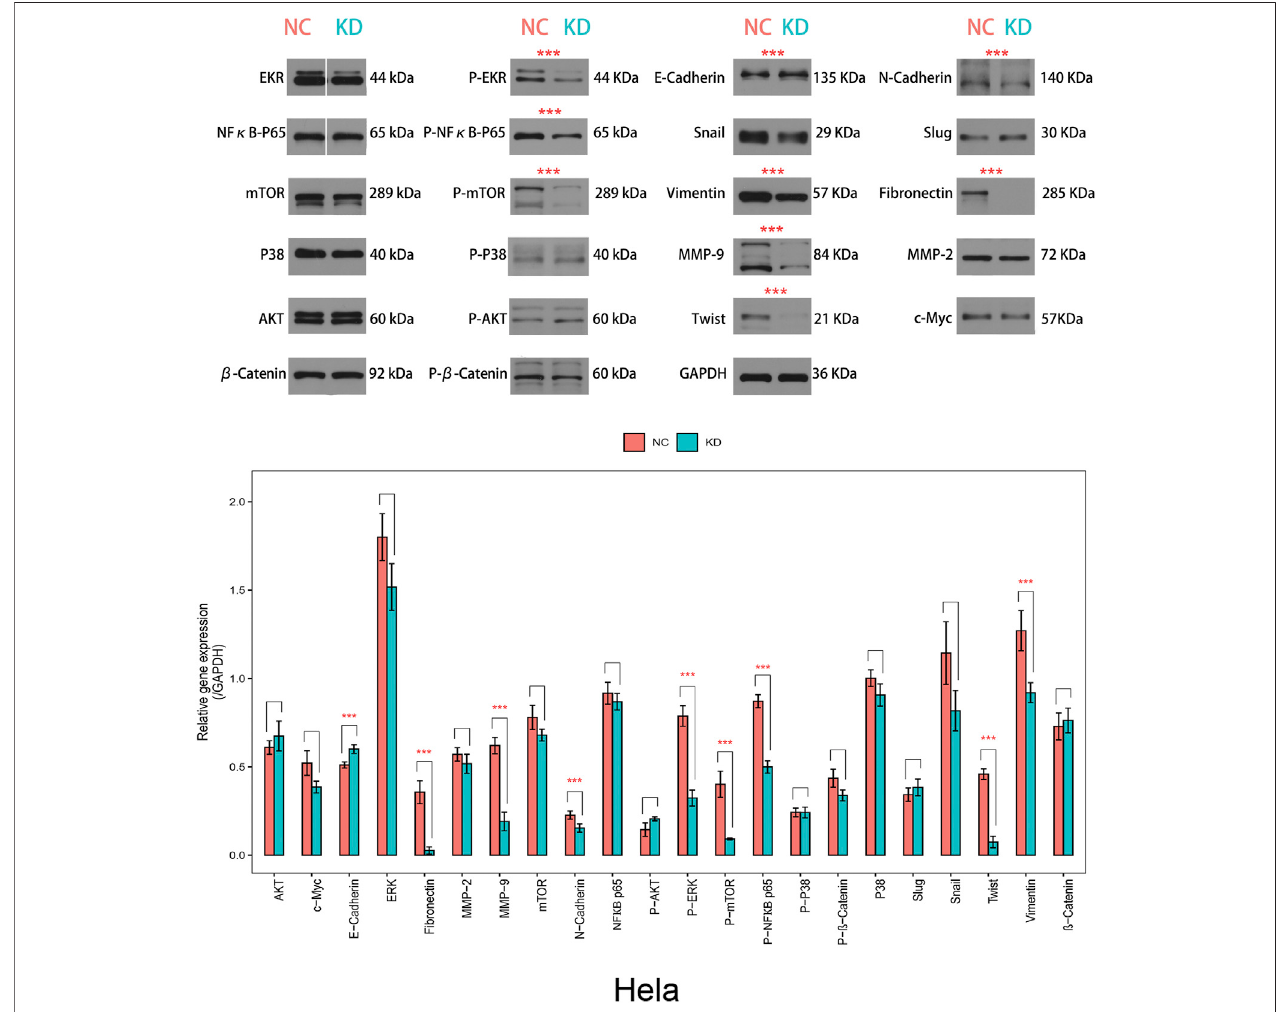
FIGURE 10 | The effect of ATG5 knockdown on the protein expression of EMT-related genes. The expression of N-cadherin, Vimentin, P-ERK, P-NF κ Bp65, P-mTOR, MMP-9, and Twist was decreased in knockdown of ATG5 group (KD) compared to control group (NC), instead, E-cadherin expression was enhanced. Error bars represent ± SD. *** p <